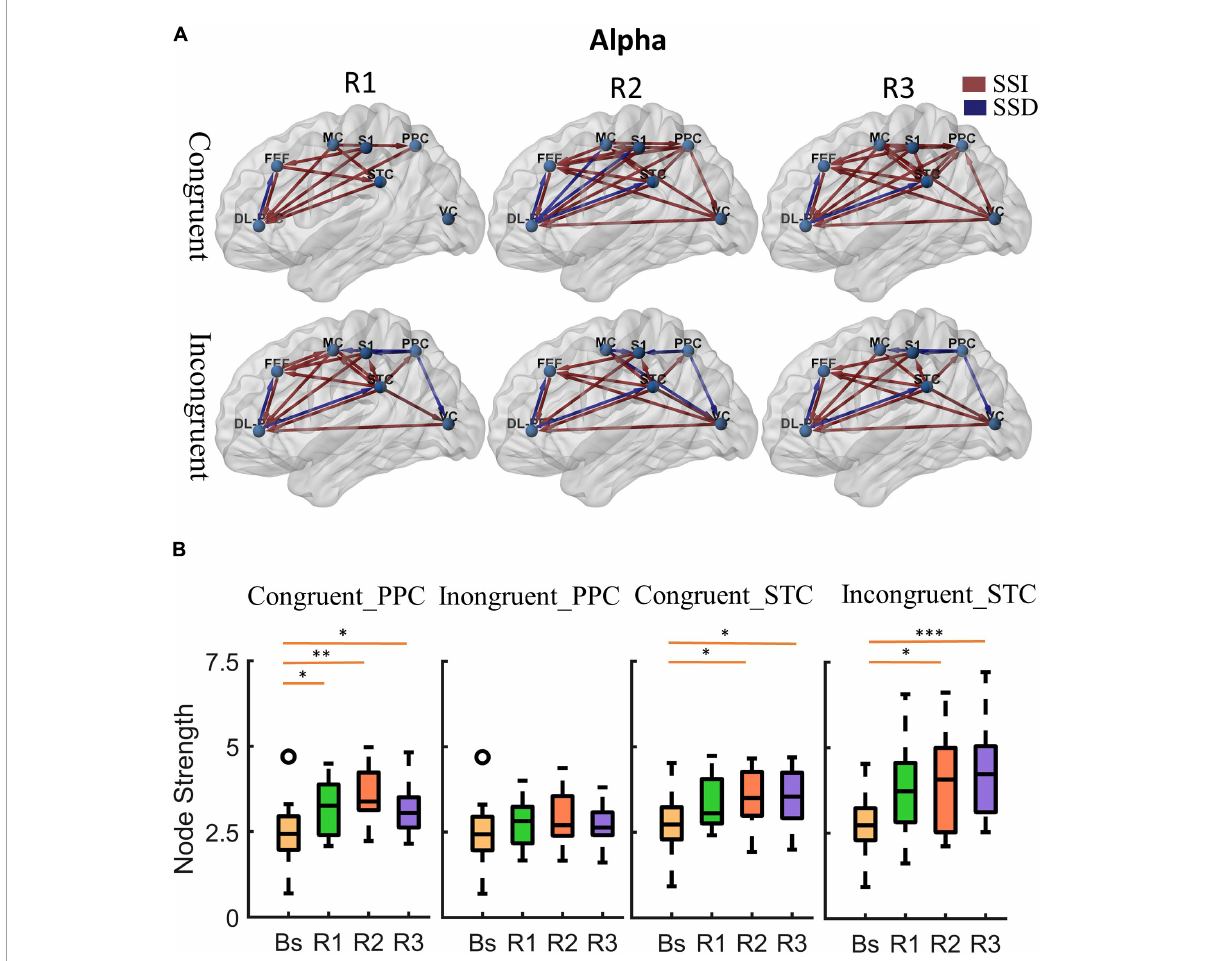
FIGURE5 Cortical activity in alpha band. (A) Changes of alpha band cortical connectivity compared to standing baseline in congruent and incongruent conditions. (B) Alpha band node strength in posterior parietal and superior temporal cortices. ∗ p < 0.05, ∗∗ p < 0.01, ∗∗∗ p < 0.001.